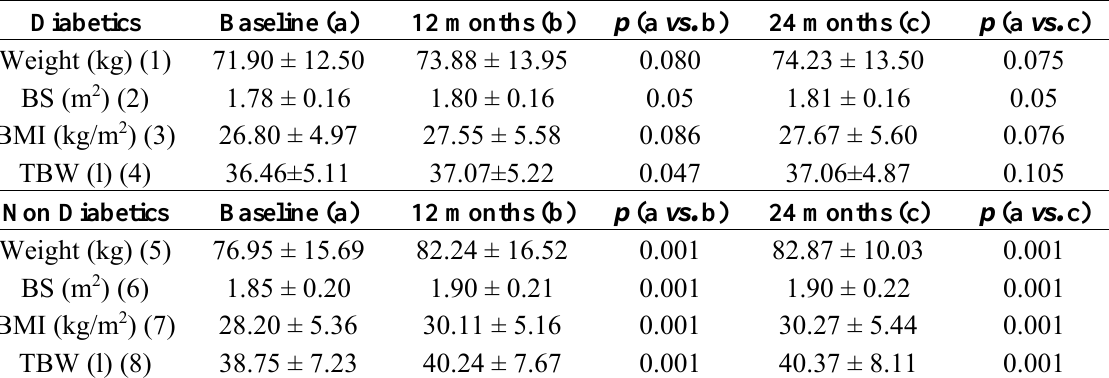
Table 2. Weight and anthropometric parameter.